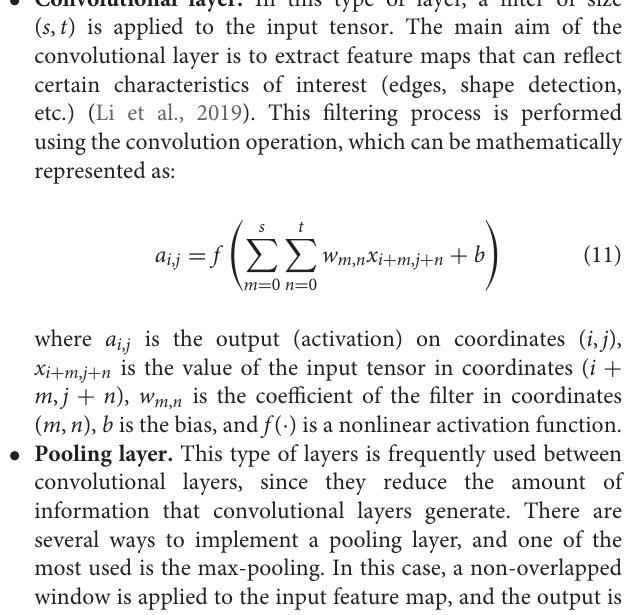
Once the WCT-referenced simulated BSP were computed, they were corrupted with additive Gaussian noise and filtered using: fourth-order bandpass Butterworth filter (fc 1 = 3 Hz and fc 2 = 30 Hz) (Figuera et al., 2016; Pedrón-Torrecilla et al.,